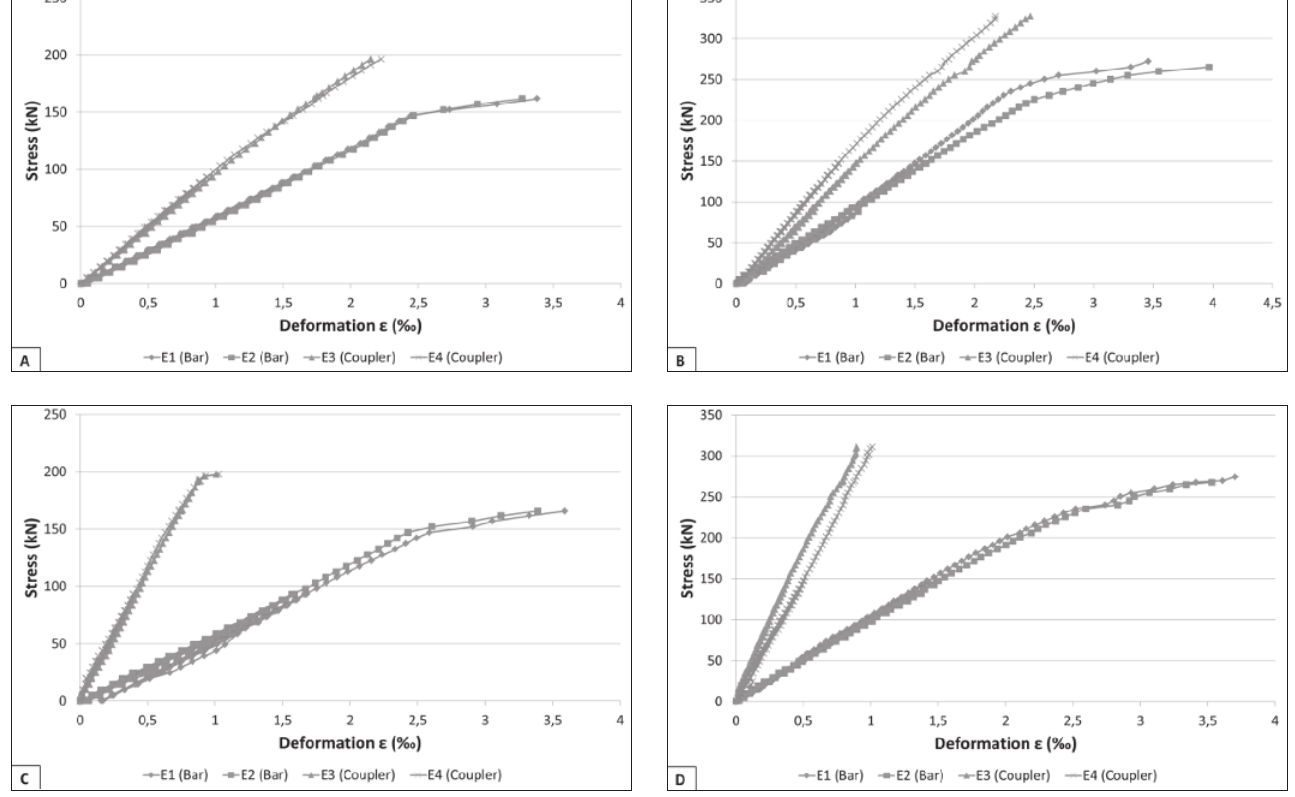
Figure 16 Stress-strain curves for mechanical splice tests. A - RC-20mm; B - RC-25mm; C - PAR-20mm and D -